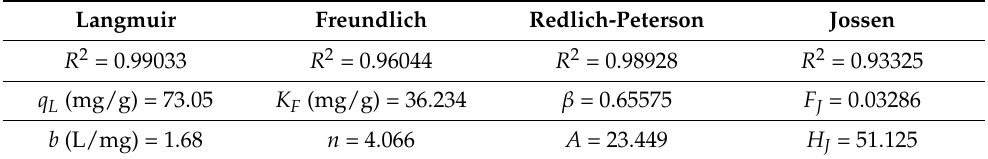
Table 3. Equilibrium adsorption isotherm parameters obtained for LVX adsorption using rGO -WO 3 heterostructure. Langmuir Freundlich Redlich-Peterson Jossen